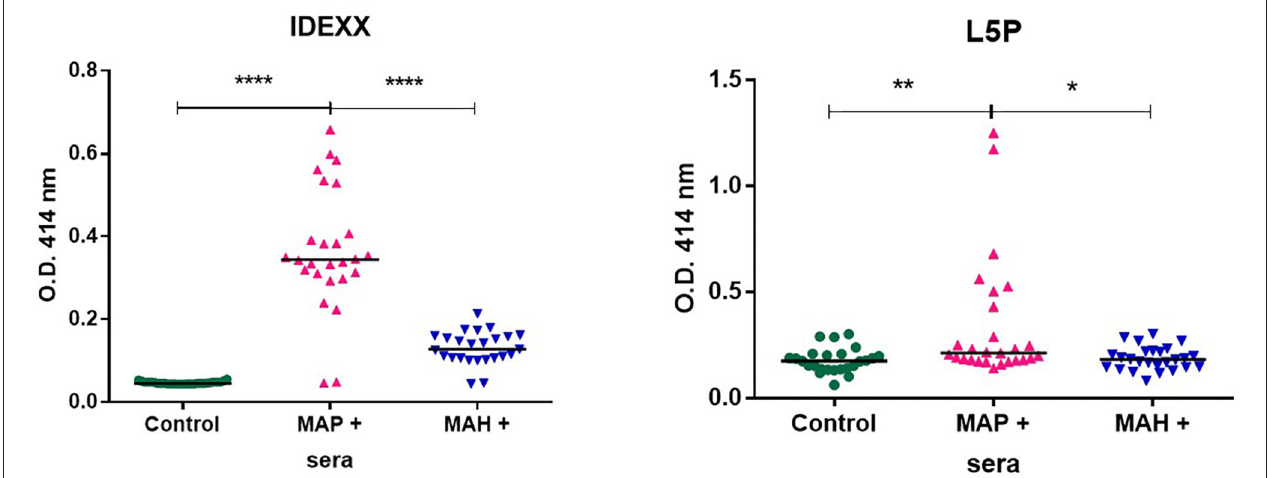
FIGURE 4 | Antibody response from goats uninfected ( n = 27) or experimentally infected with MAP ( n = 25) or MAH ( n = 26), as analyzed by IDEXX test or using L5P antigen. Results are shown as OD450nm of individual samples and medians are indicated as a black line. The statistical differences between the groups were determined using the non-parametric Mann–Whitney test. Significantly different when p < 0.05. * p < 0.05, ** p < 0.01, and **** p < 0.0001.